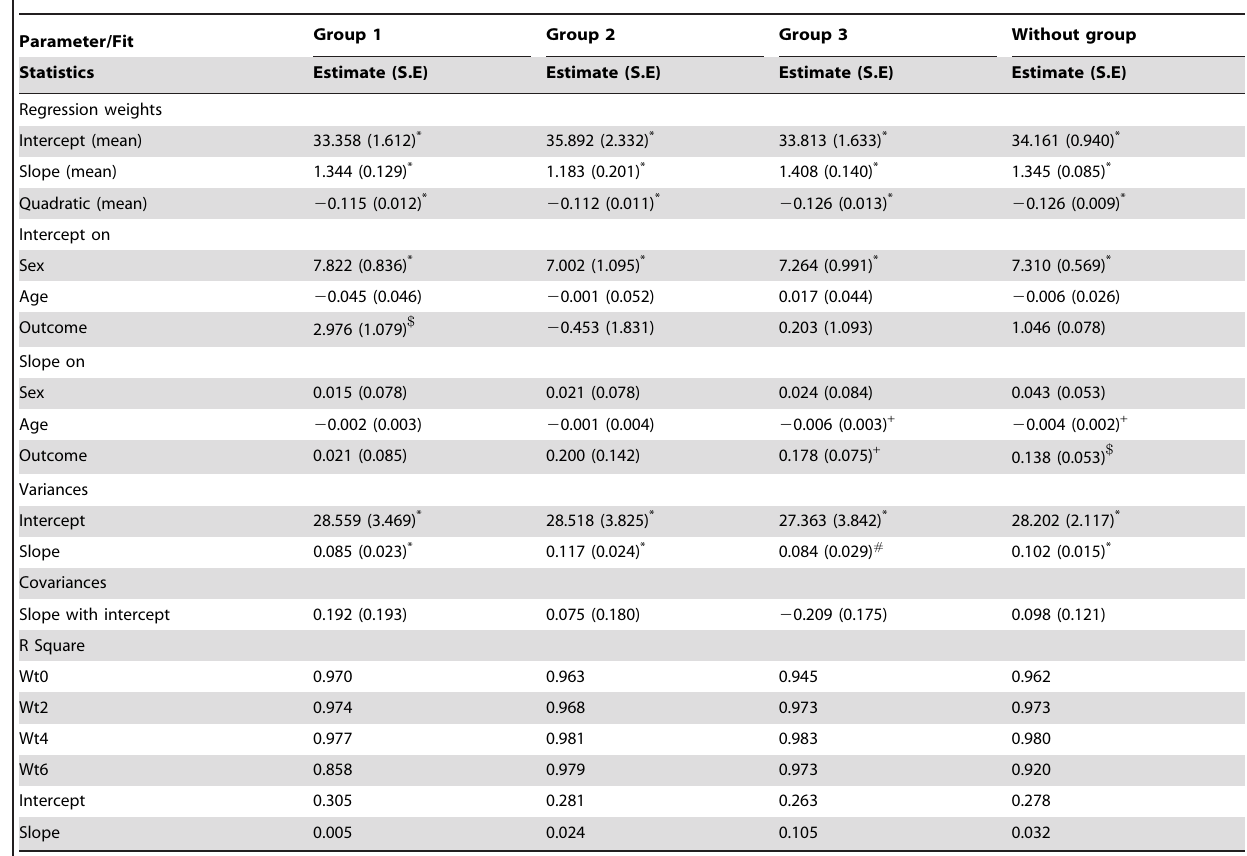
Table 3. Parameter Estimates of quadratic